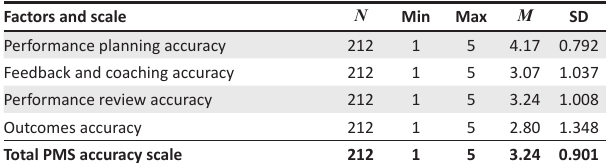
TABLE 2: Employees’ perceptions of the performance management system accuracy. TABLE 1: Cronbach’s alpha coefficients of the performance management system